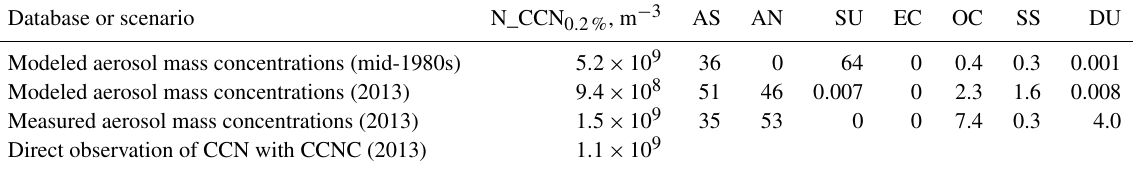
Table 4. Average CCN number concentration (m − 3 ) and average contribution (%) of the considered species to the total CCN number concentration at ground level for a supersaturation of 0.2% at the HOPE site Melpitz for the two 2013 campaigns and the corresponding periods of the mid-1980s scenario. The values were calculated from aerosol mass concentrations modeled with COSMO-MUSCAT and from aerosol mass concentrations observed by gravimetrical measurements. In addition, the average CCN number concentration measured in situ is shown for